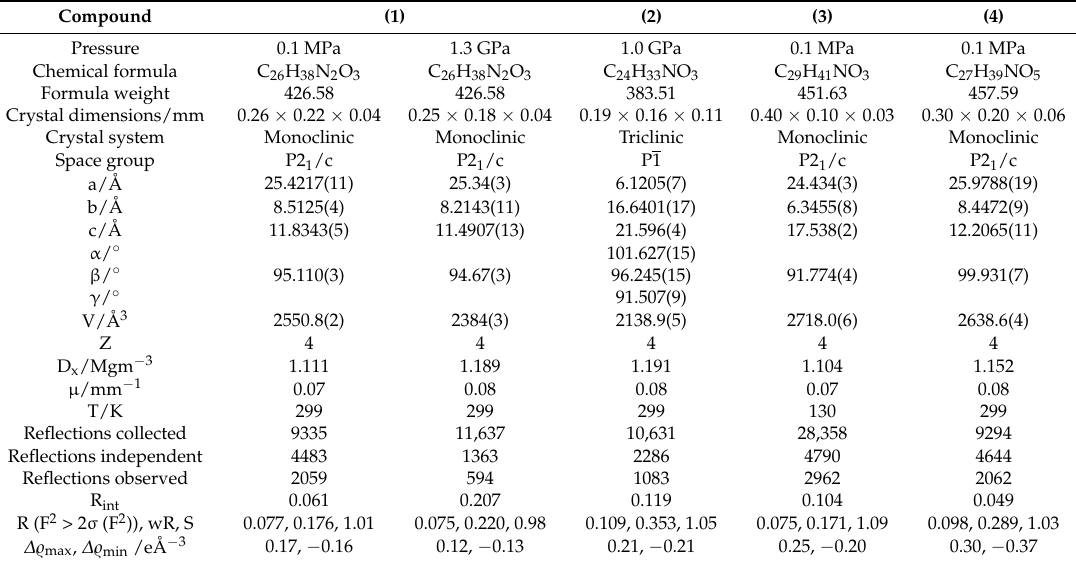
Table 1. The crystallographic and experimental data for ( 1 )–( 4